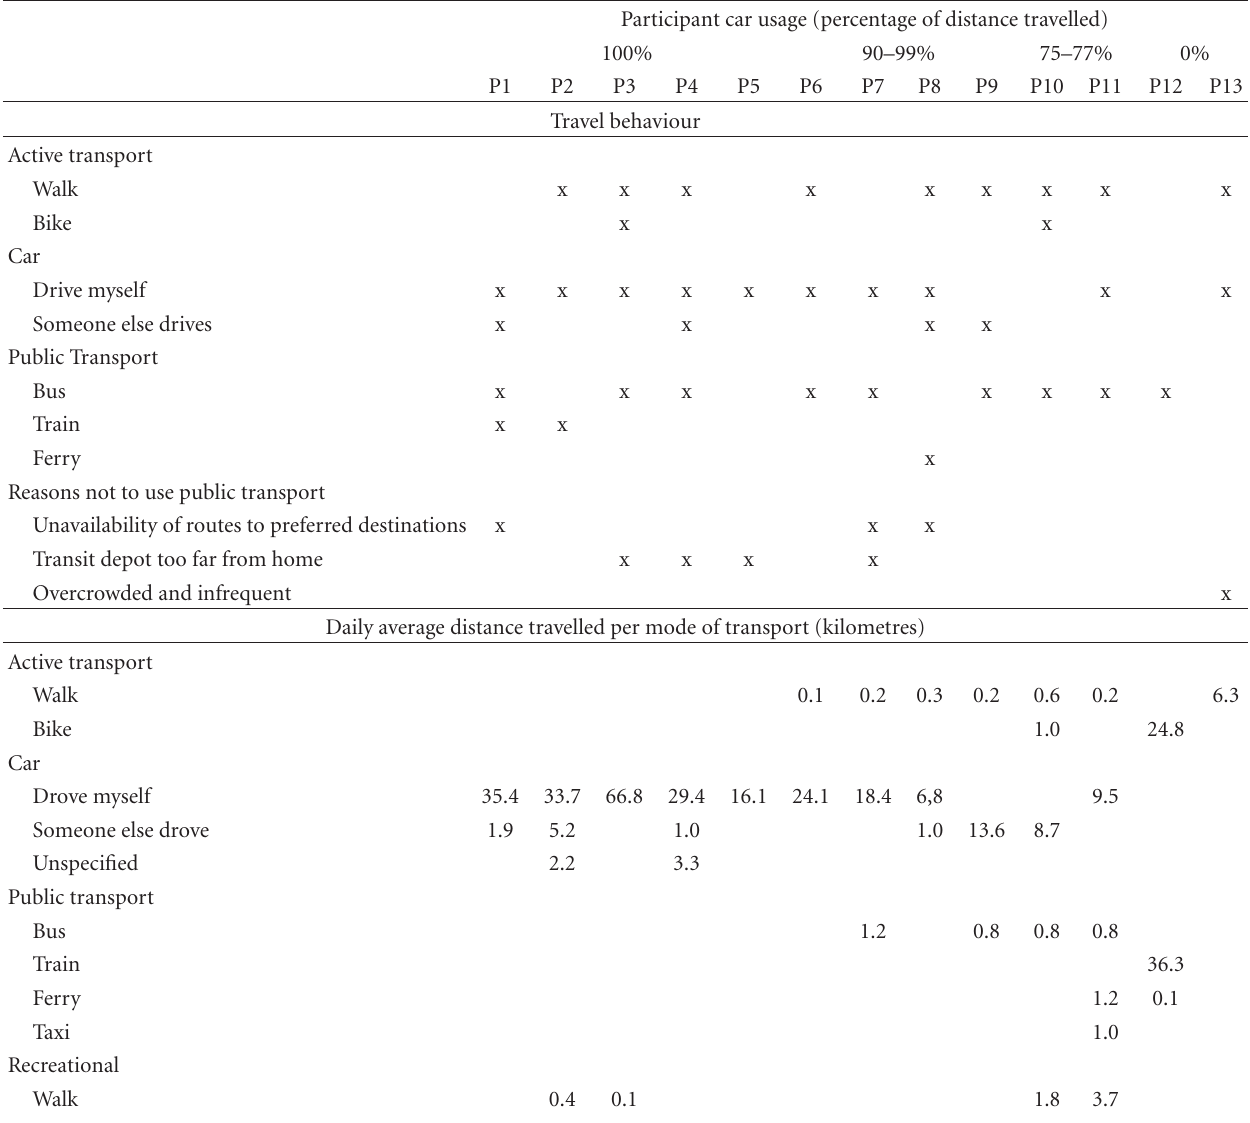
Table 3: Travel behaviour and daily average distance travelled by mode of